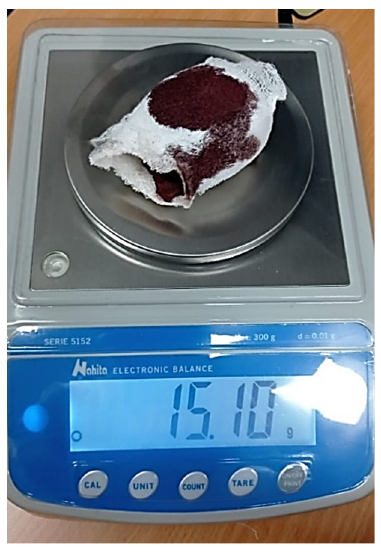
Figure 4. The image shows one of the weighing performed on a bandage of one of the experimental